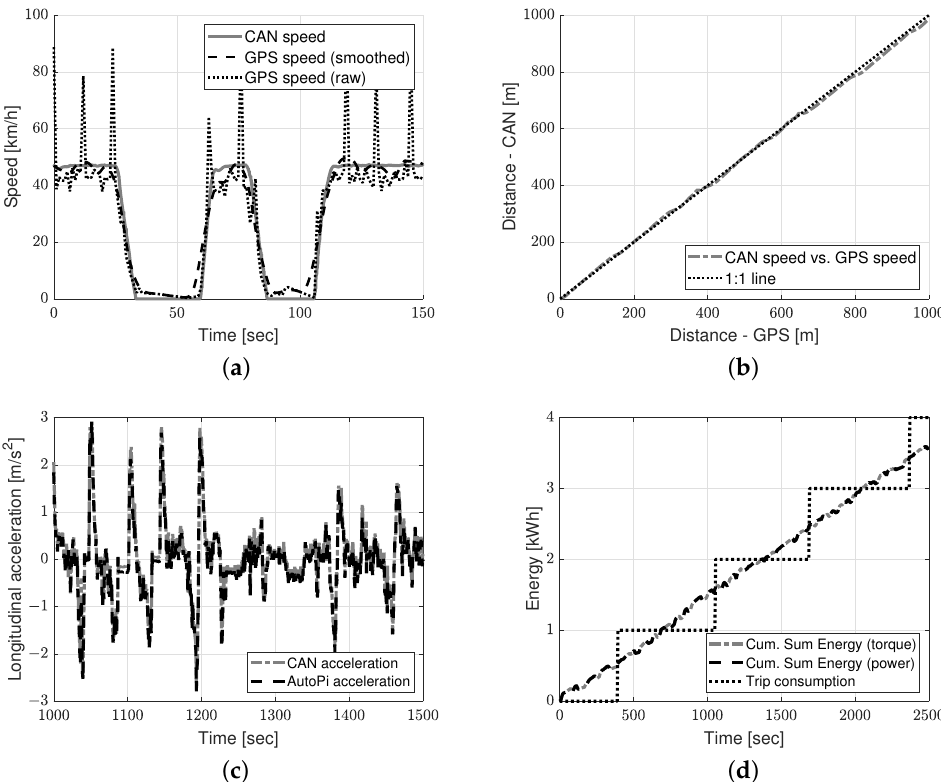
Figure 3. Validation of data collection platform: ( a ) speed from Can bus versus speed calculated from AutoPi GPS sensor, ( b ) distance calculated from CAN bus speed versus distance calculated from GPS speed, ( c ), CAN bus acceleration versus AutoPi acceleration, and ( d ) cumulative sum of instant energy consumption calculated versus the total measured trip energy